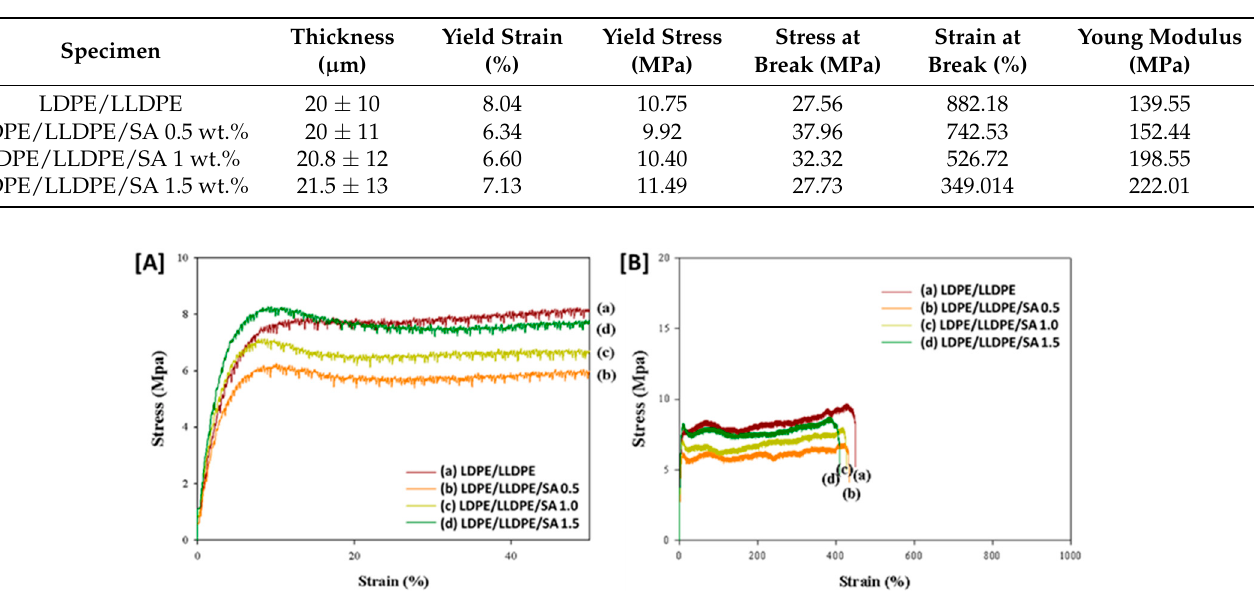
Figure 5. The stress–strain curve for the LDPE/LLDPE blend polymer films with various SA contents: (a) 0 wt.%, (b) 0.5 wt.%, (c) 1 wt.%, and (d) 1.5 wt.%. ( A ) from 0 to 90% and ( B ) from 0 to 1500%. The samples were cut along the MD. Table 2. The mechanical properties of the LLDPE/LDPE/SA (0–1.5%) air blown composite films along the MD.